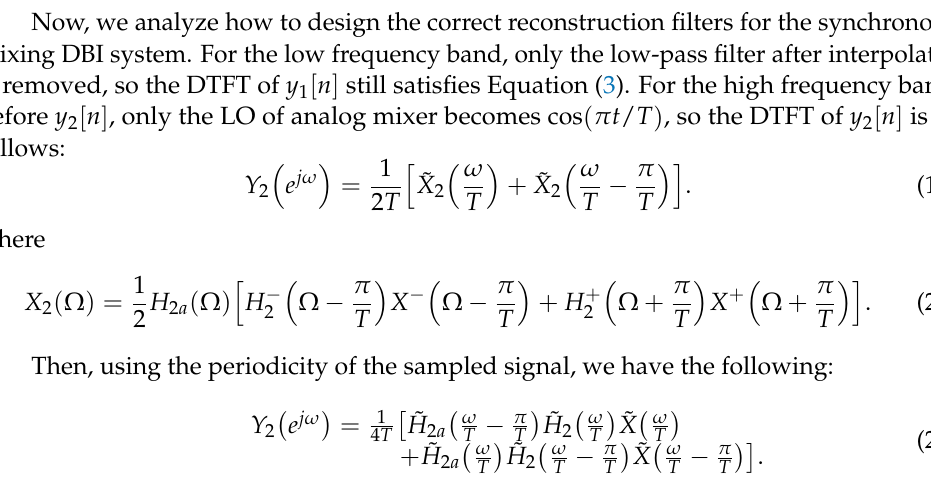
Figure 8. Synchronous mixing DBI